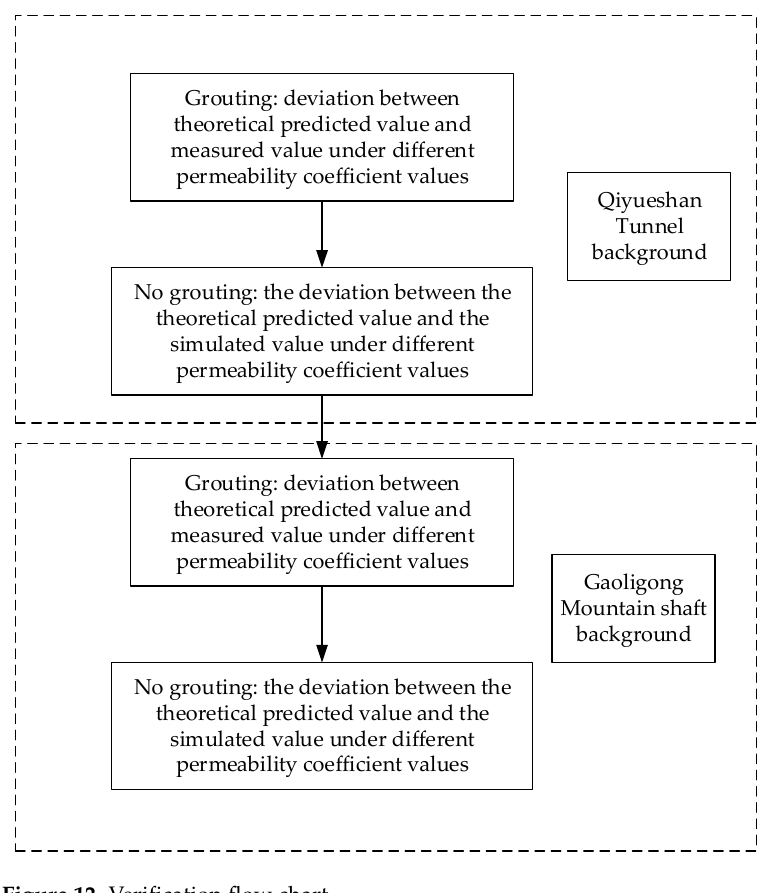
Figure 12. Verification flow chart.